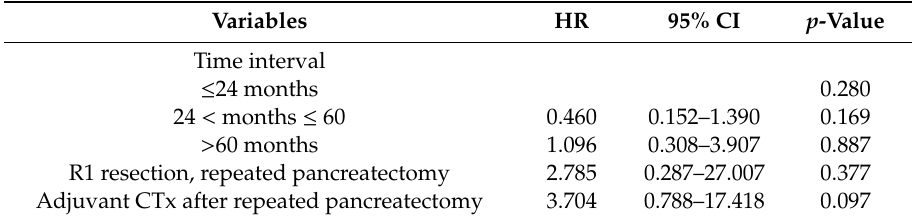
Table 3. Univariate analysis of the predictors of overall survival after repeated